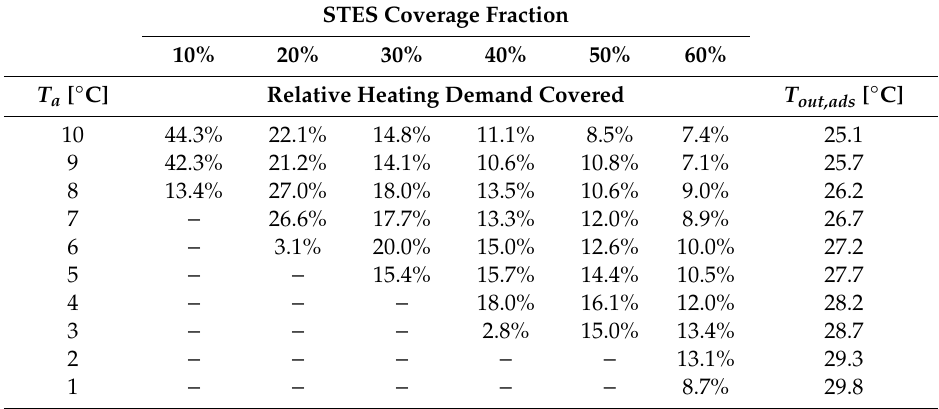
Table 2. Analysis of the heating distribution as a function of the expected STES coverage fraction, for Regensburg. The table also reports the ambient temperature and the relative supply temperature needed by the floor heating